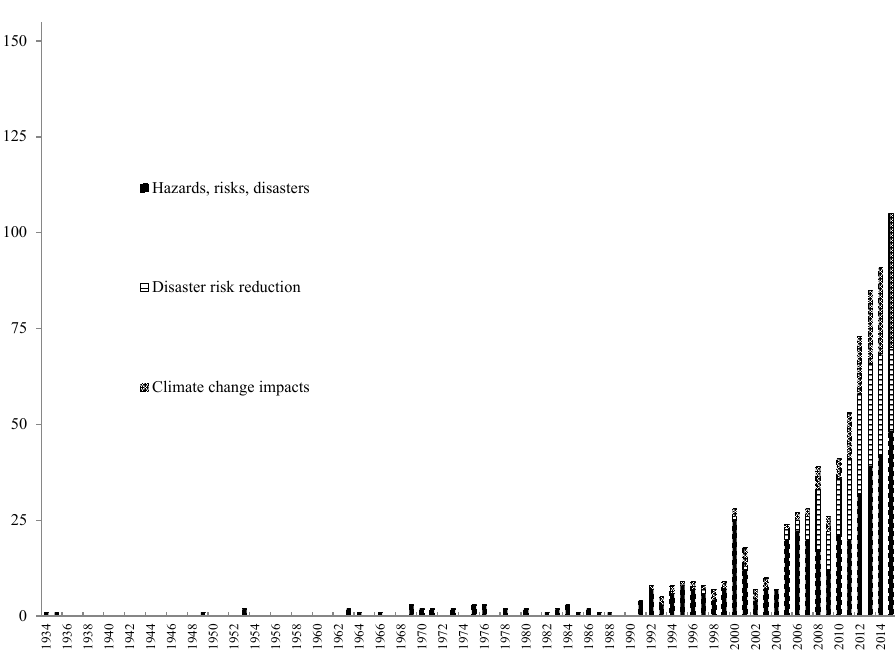
Figure 1. Number of publications over